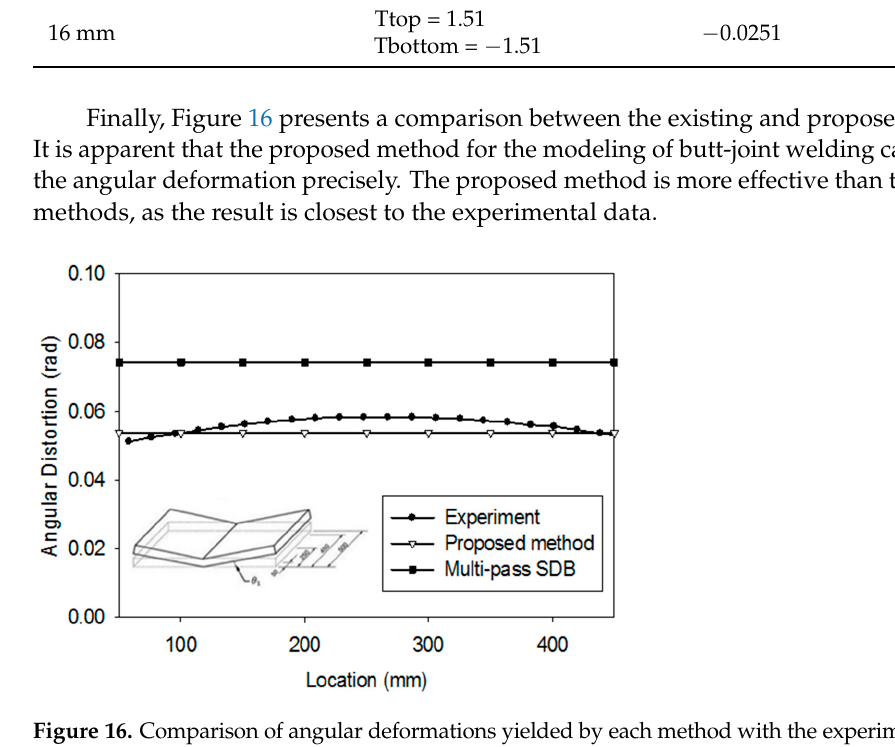
Figure 15. Angular distortion: multi-pass SDB method (mm unit). Table 7. Input variables for multi-pass SDB method.